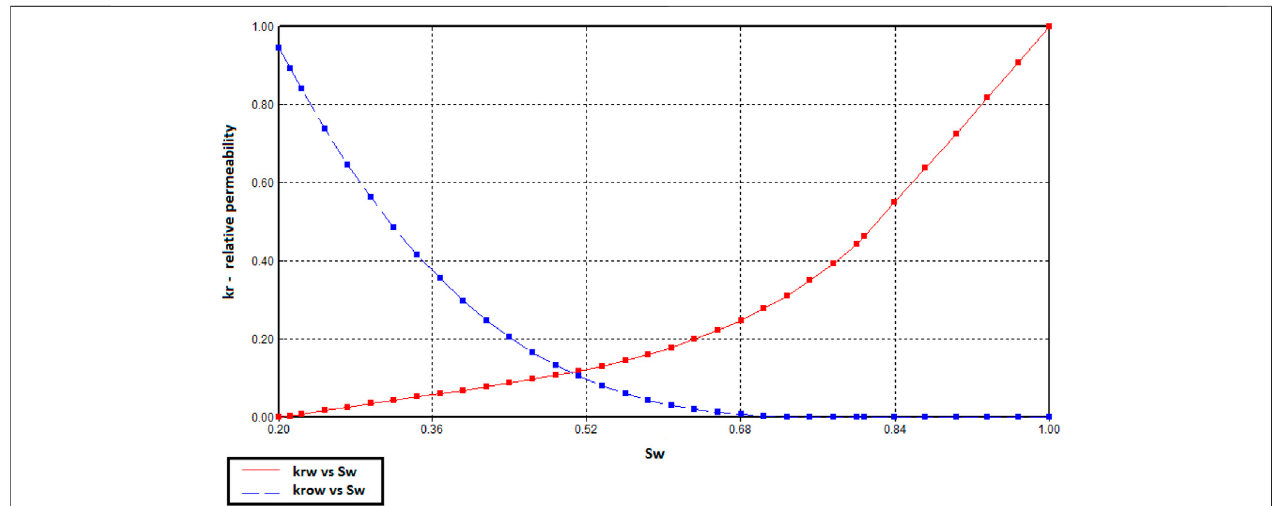
FIGURE 2 | Water and oil relative permeability curves as a function of water